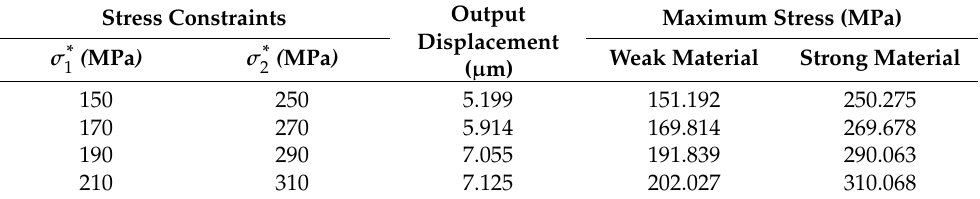
Table 2. Optimal results for compliant gripper under different stress constraint